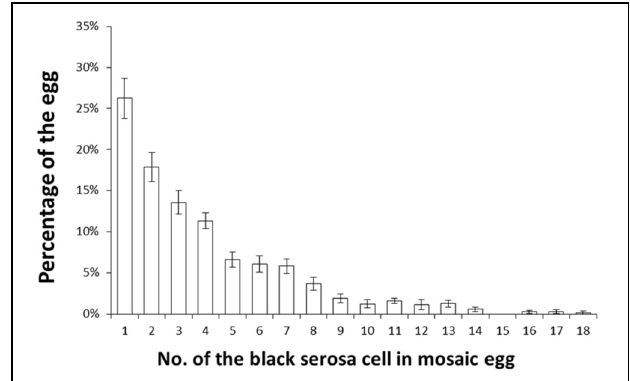
FIGURE 5 | Percentage of white eggs with the indicated number of black serosal cells. Eleven randomly selected batches obtained from pe / + pe females crossed with pe / pe males were examined. More than 100 white eggs per batch were investigated. Error bars represent standard errors. The maximum number of black serosal cells in a white egg was 18.